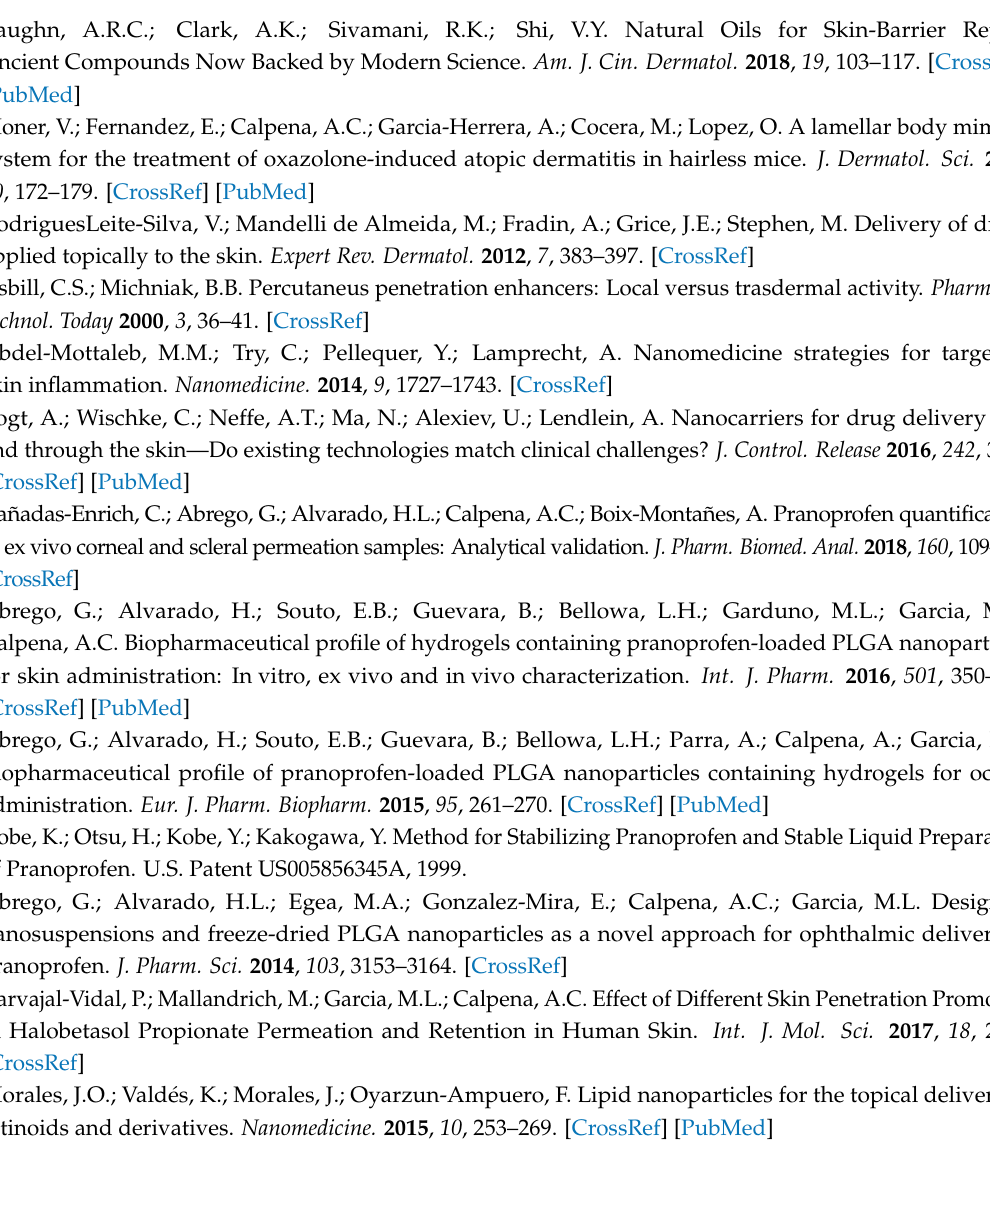
levels in experimental design, Table S3: Design of experiments of PF loaded Lipid NLCs, Table S4: Average particle size of optimized formulations determined by laser diffraction (LD), Figure S1: NLCs F-3-L and NLCs F-9-L backscattering profiles obtained by the Turbiscan®Lab®stored at 25 ◦ C, Figure S2: Skin irritation testing. Draize